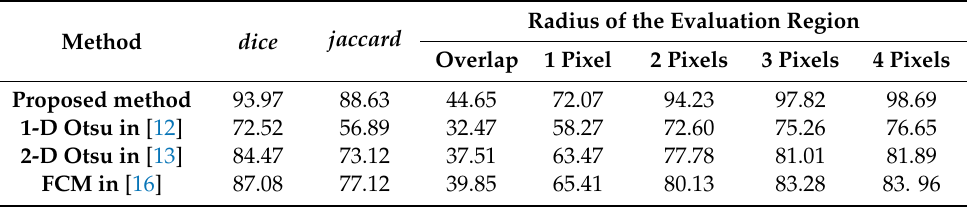
Table 2. Comparison of riverway extraction accuracy of each method